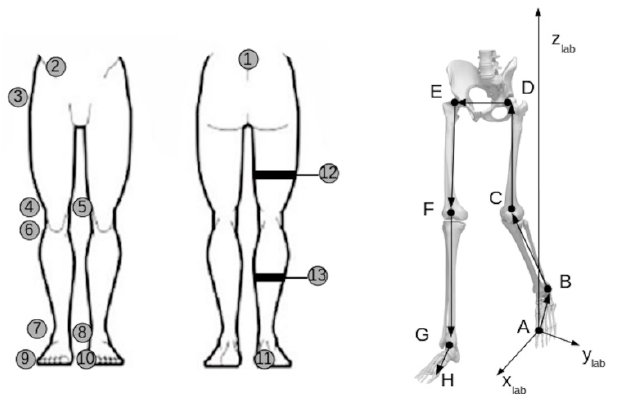
Figure 2. On the left panel, half (right side) body marker set is reported as follows: 1. middle point between posterior iliac spines; 2. anterior iliac spine; 3. prominence of the greater trochanter external surface; 4. lateral epicondyle of the femur; 5. medial epicondyle of the femur; 6. head of the fibula; 7. lateral malleolus; 8. and medial malleolus; 9. 5th metatarsal head; 10. 1st metatarsal head; 11. calcaneus; 12. marker rigidly attached to a wand over midfemur; 13. marker rigidly attached to a wand over midshaft of the tibia. On the right side, the 7-segments kinematical model is reported. Axes x lab , y lab , and z lab refer to the lab-related reference frame.